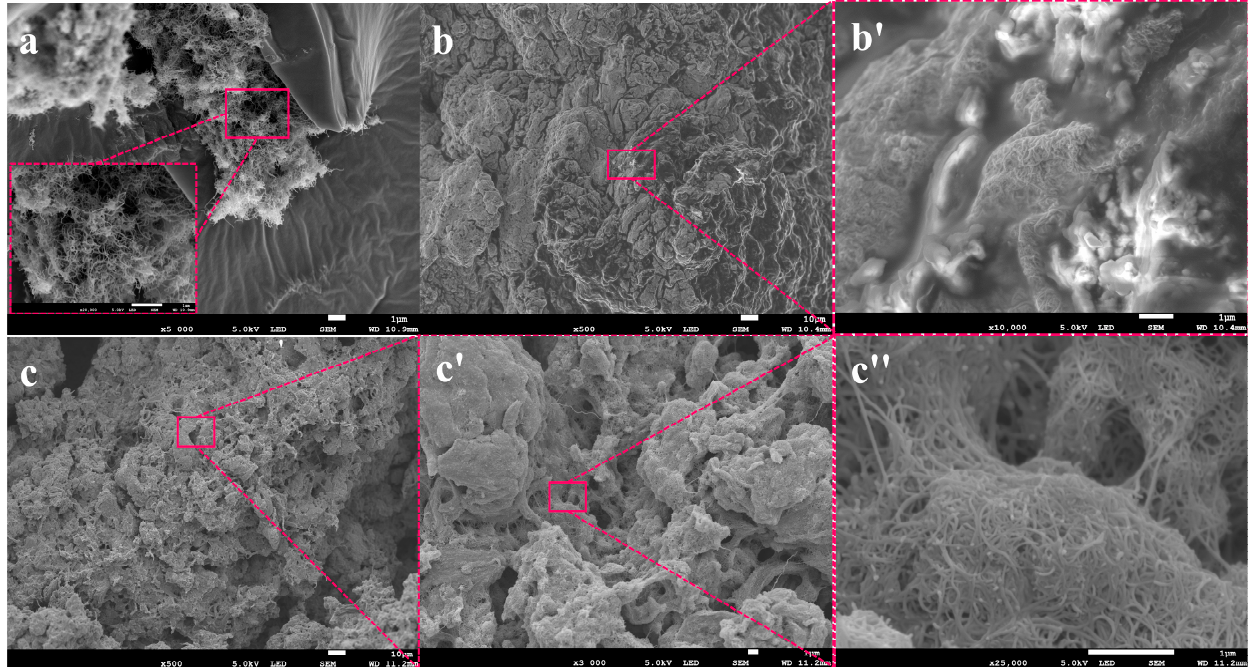
Figure 5. SEM images of cross-section of CNTs/OCWPU composites films with different CNTs content: ( a ) 2.5% wt%. ( b , b ′ ) 10% wt%. ( c , c ′ , c ″ ) 30% wt%. content: ( a ) 2.5% wt%. ( b , b (cid:48) ) 10% wt%. ( c , c (cid:48) , c (cid:48)(cid:48) ) 30%